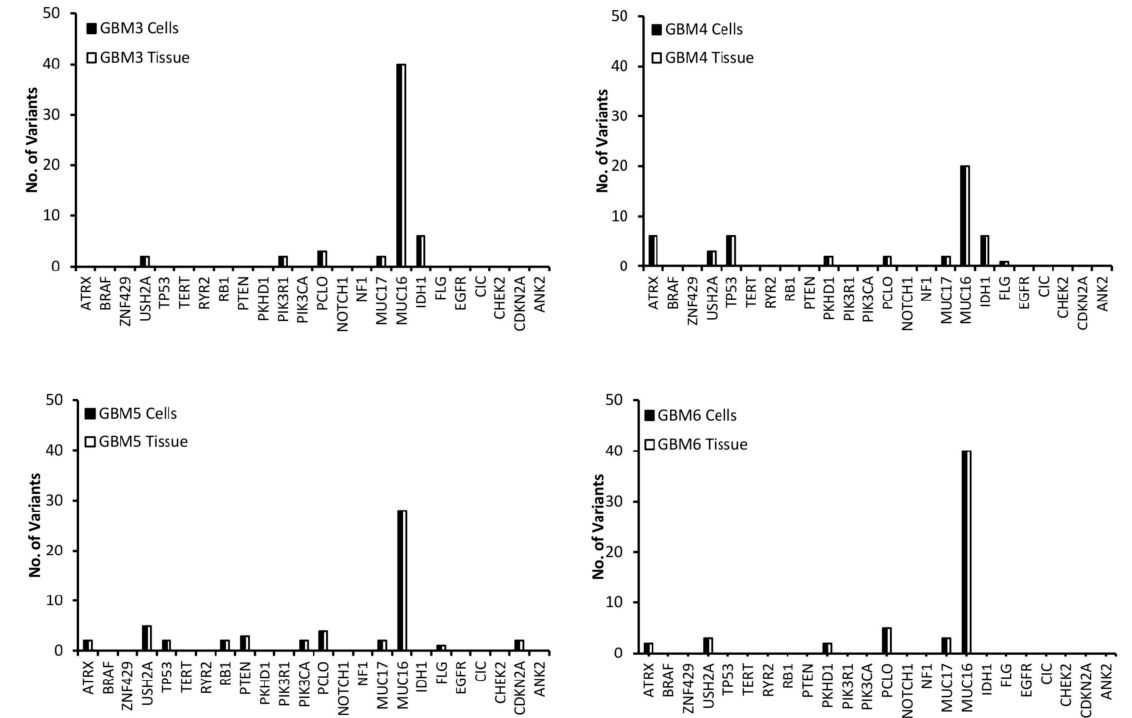
Figure 2. The number of exonic, nonsynonymous variants for the top 25 most frequently mutated genes in GBM according to the Catalogue of Sonic Mutations in Cancer (COSMIC) database in both the tissue and corresponding cells.